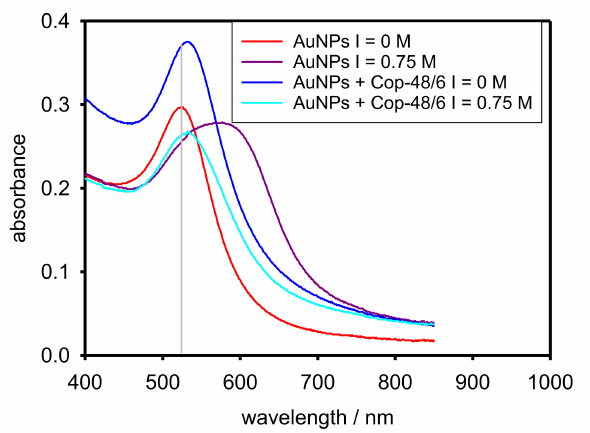
Figure 6. UV-vis spectra of the nanocomposite (AuNPs + Cop-48/6) at 25 ◦ C in varying NaCl concentrations. For an illustrative comparison, UV-vis spectra of AuNPs are also